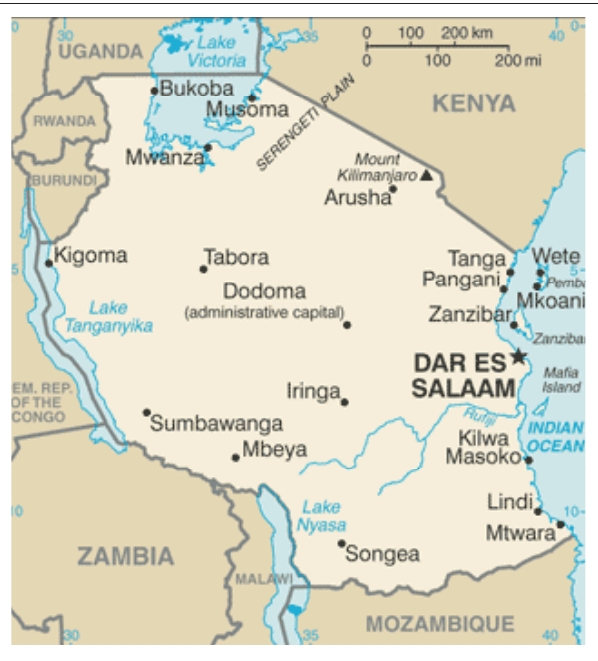
FIGURE 1: Map of Tanzania with indication of the three regions from where isolates were